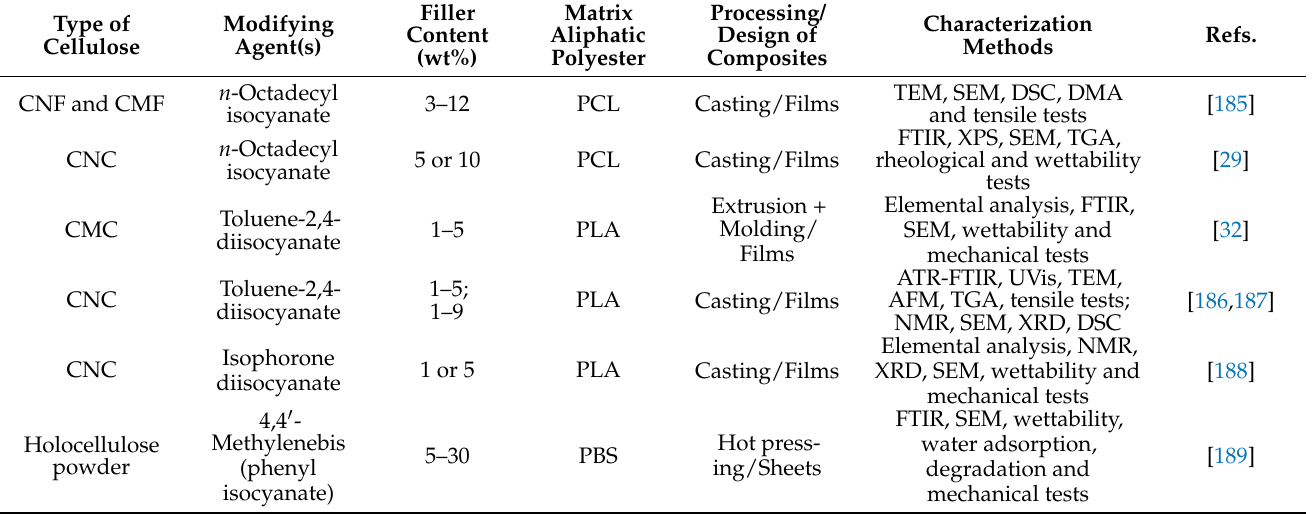
Table 7. Summary on covalent modification of cellulose micro- and nanomaterials with alkyl/aryl isocyanates for the preparation of composites with aliphatic